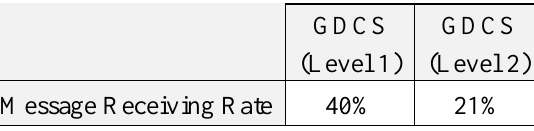
Table 4. Message receiving